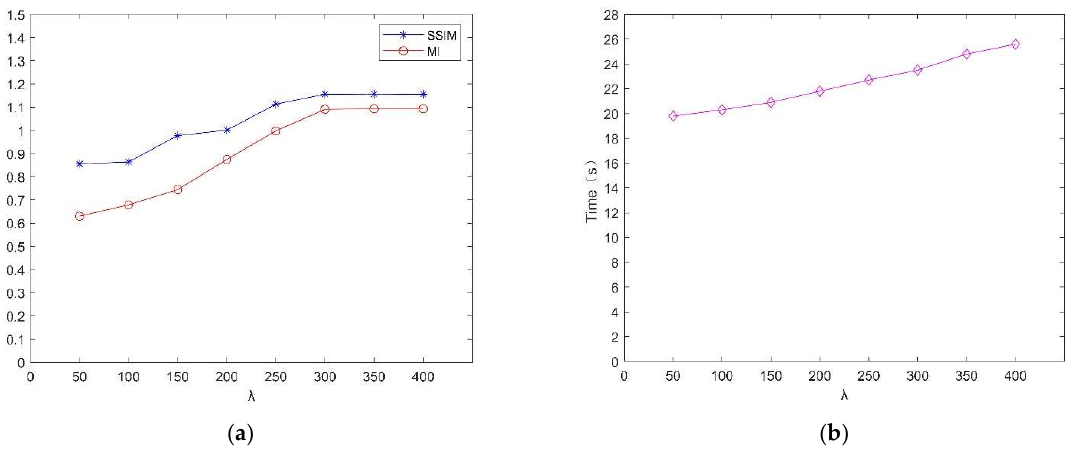
Figure 6. Quantitative evaluation of the fused images produced by different 𝜆 . (( a ) represents the quality evaluation value of different 𝜆 , and ( b ) represents the consumption time of different 𝜆 .)